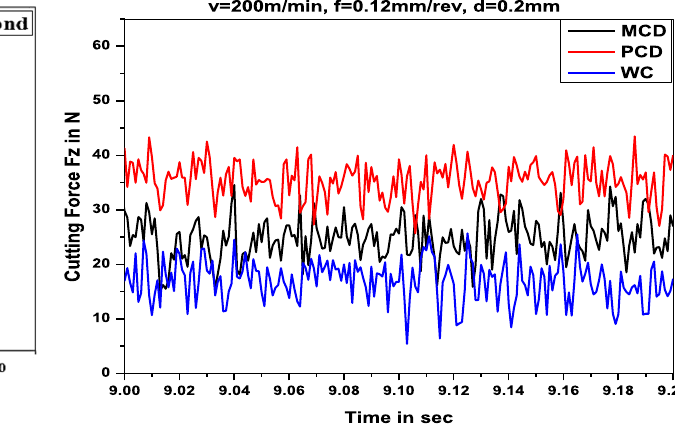
Fig. 6. Dynamic component of cutting force vs. time graph at v = 200m/min, f =0.12 mm/rev, d = 0.2mm.